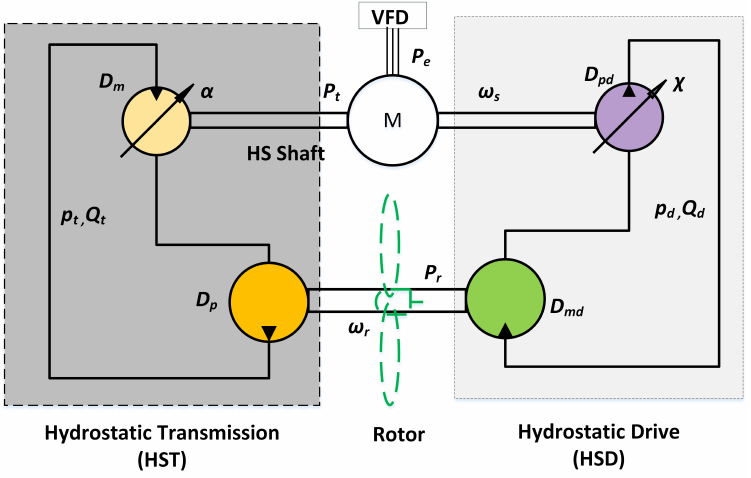
Figure 2. Schematic of a power-regenerative test platform.